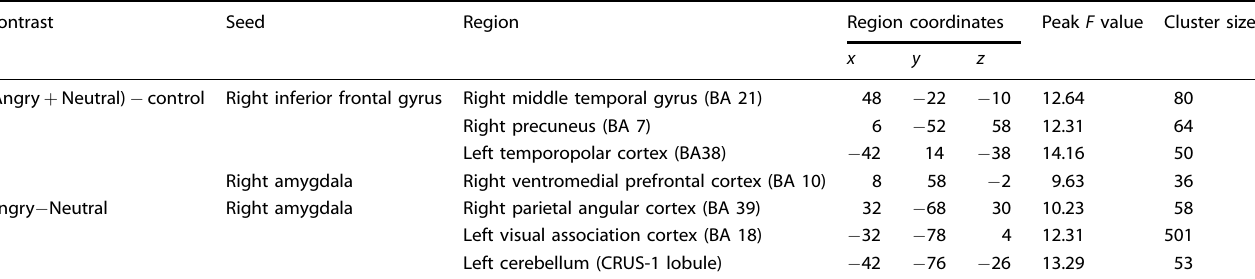
Table 3. Between-group connectivity differences. Contrast